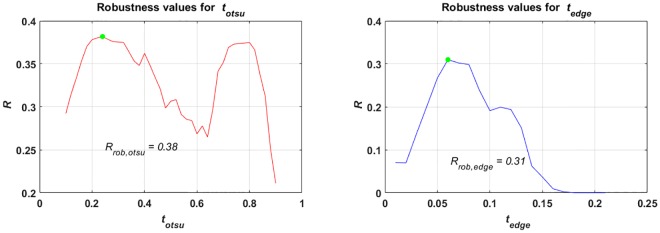
(Case 1) Results for the selection of robust image segmentation parameters i.e. totsu in case of Otsu segmentation and tedge in case of Sobel edge detection for whole data set (r = 1).R vs. totsu for the figure on top and R vs. tedge for the figure at the bottom. The green dot in both figures represents robust selection of the respective parameters i.e. trob,otsu = 0.24 for Otsu segmentation and trob,edge = 0.06 for Sobel edge detection.